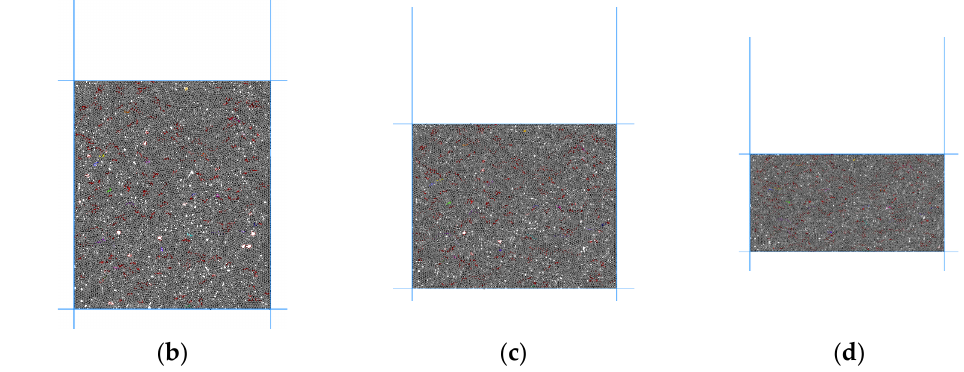
Figure 16. Crushing form of modified cement slurry under different slip amounts: ( a ) 5 mm; ( b ) 10 mm; ( c ) 15 mm; ( d ) 20 mm.